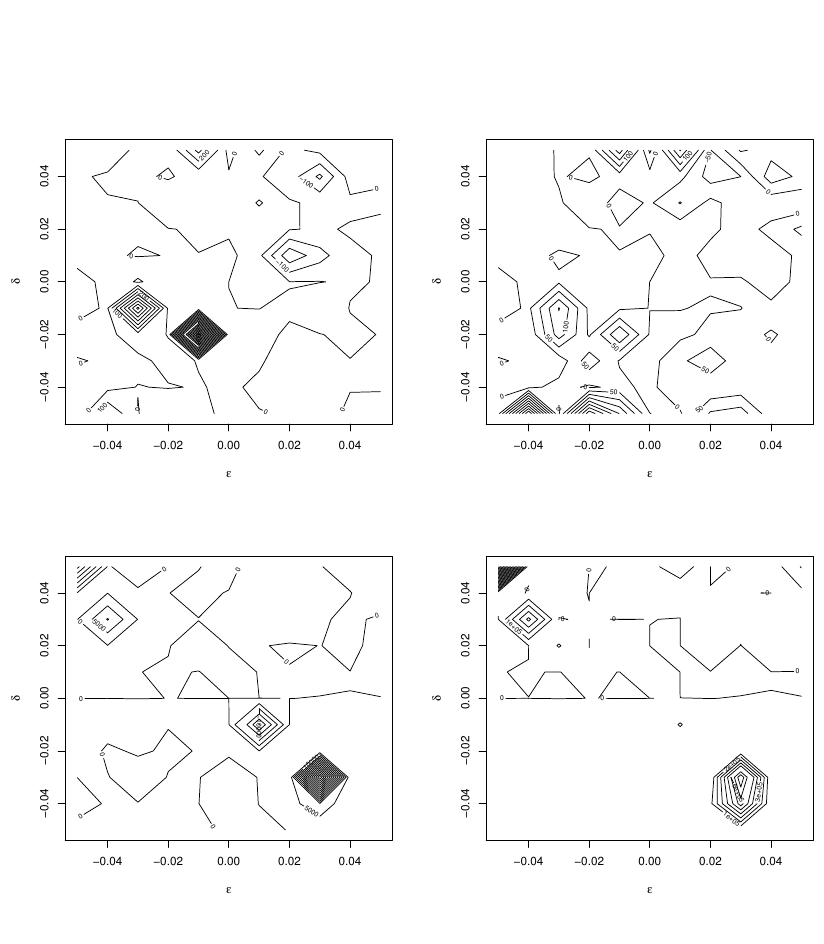
Figure 2 – Contours of the relative percentage changes in the bias of the estimator of α (top left), the MSE of the estimator of α (top right), the bias of the estimator of β (bottom left) and the MSE of the estimator of β (bottom right) when n =